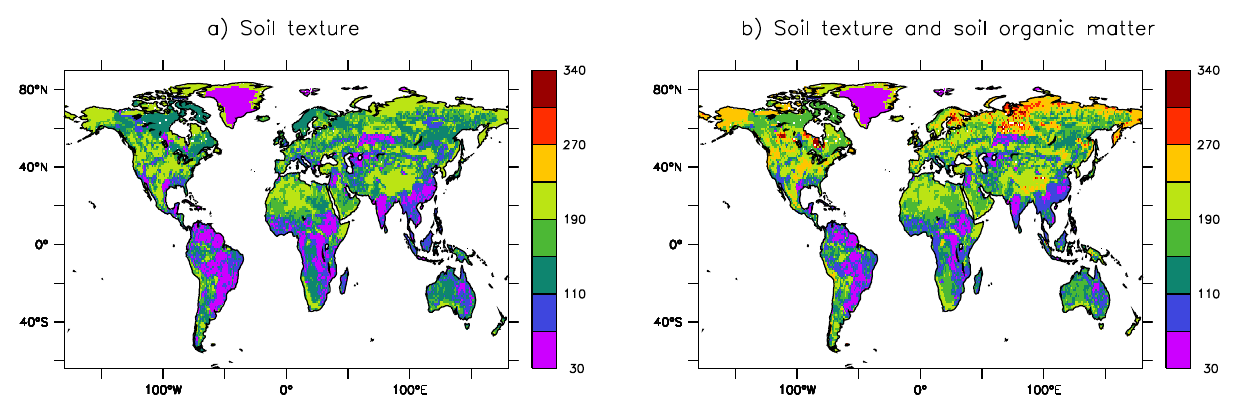
Fig. A1. Spatial variability in soil water holding capacity introduced in the initial version of ORCHIDEE (RU). Spatial soil water holding capacity computed using both soil texture and soil organic content (b) is used in all ORCHIDEE versions described in this paper (Fig. 1). Spatial soil water holding capacity computed using only soil texture is given in (a) for